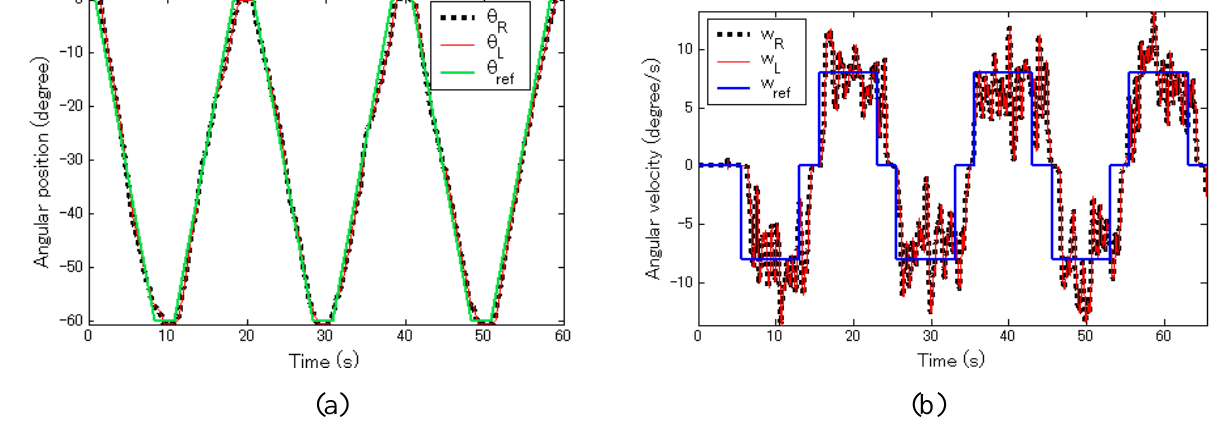
Figure 7. A representative motion tracking trajectory and the corresponding velocity